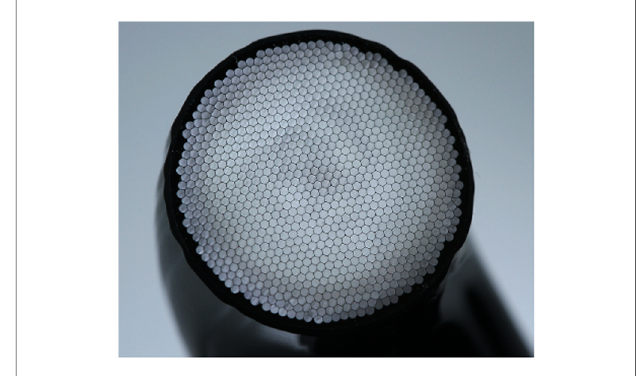
FIGURE 4 Construction of a LCU optic tip containing a glass- fi bre bundle (Bluephase PowerCure, Ivoclar